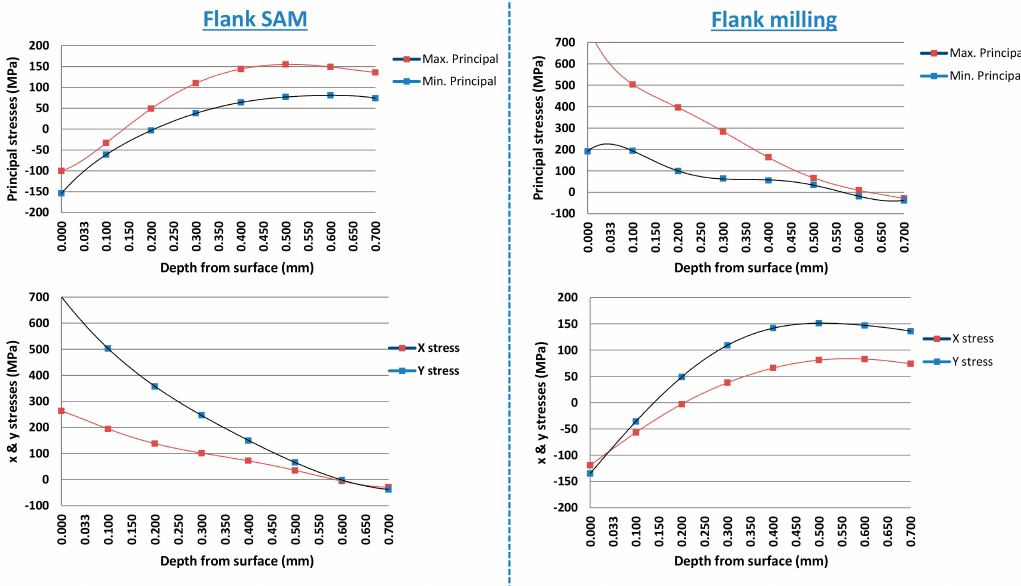
Figure 7. Residual stresses obtained for flank SAM and flank milling on Inconel ®